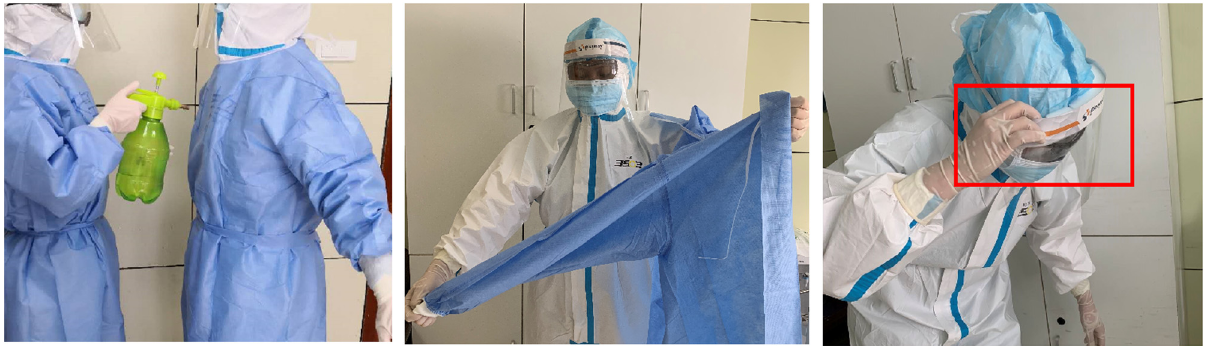
Figure 2: A representative image showing incorrect methods for disinfectant spraying, the isolation gown moving, and face shield removal.